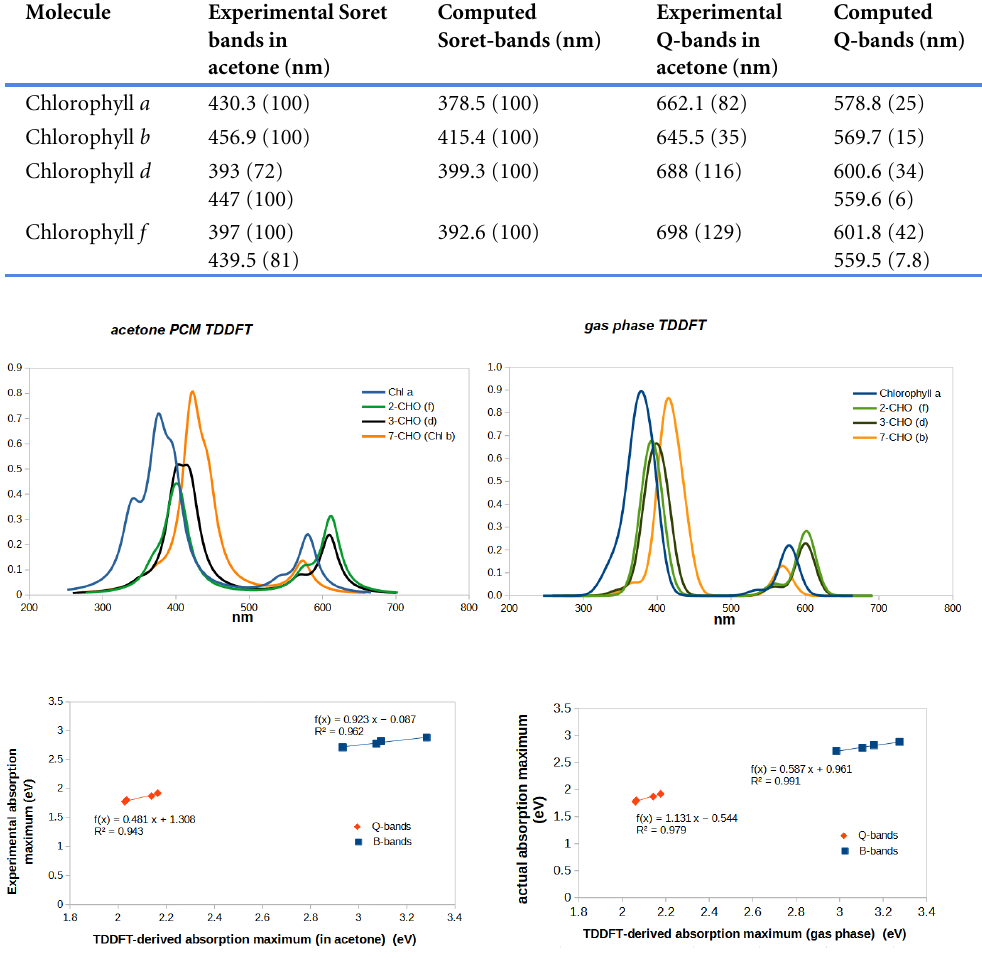
Figure 3 Correlation between experimental and predicted absorption maxima of the B- and Q-bands on chlorophylls a , b , d , and f . For molecules with two separated absorption bands in the same region, the predicted absorption band was plotted against the wavelength of the lower-energy experimental absorp- tion. Full-size DOI: